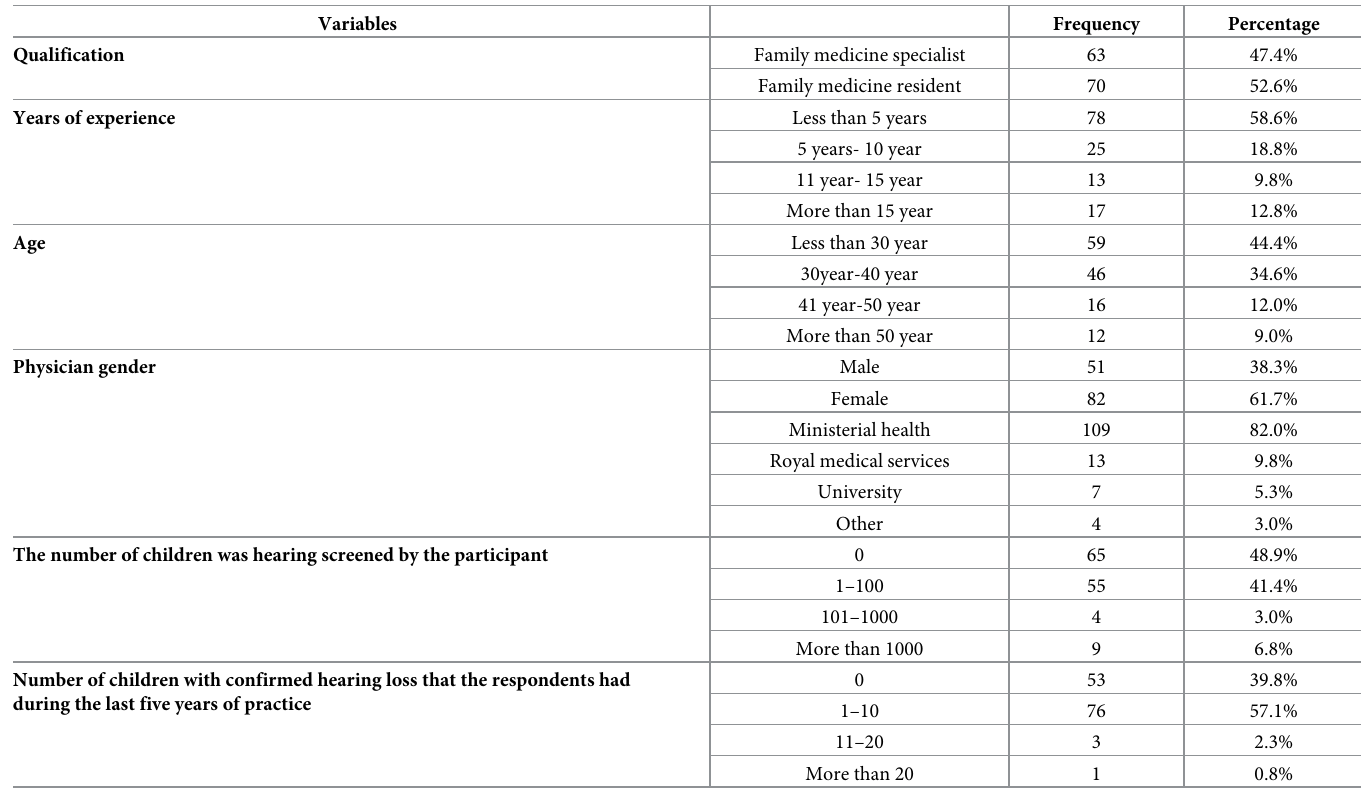
Table 1. Sociodemographic characteristics of the